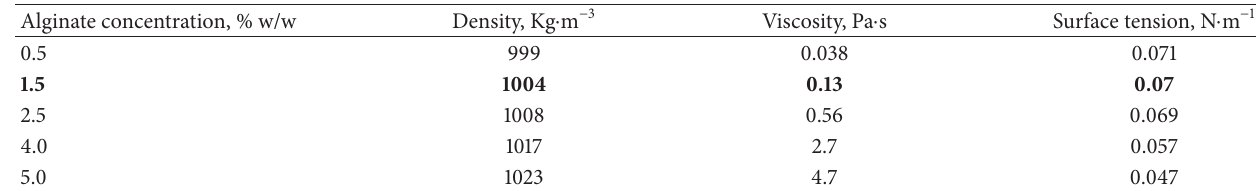
Table 3: Physical properties of Manugel GHB alginate solutions: the properties of a solution with a concentration of 1.5% (w/w) are in bold font.